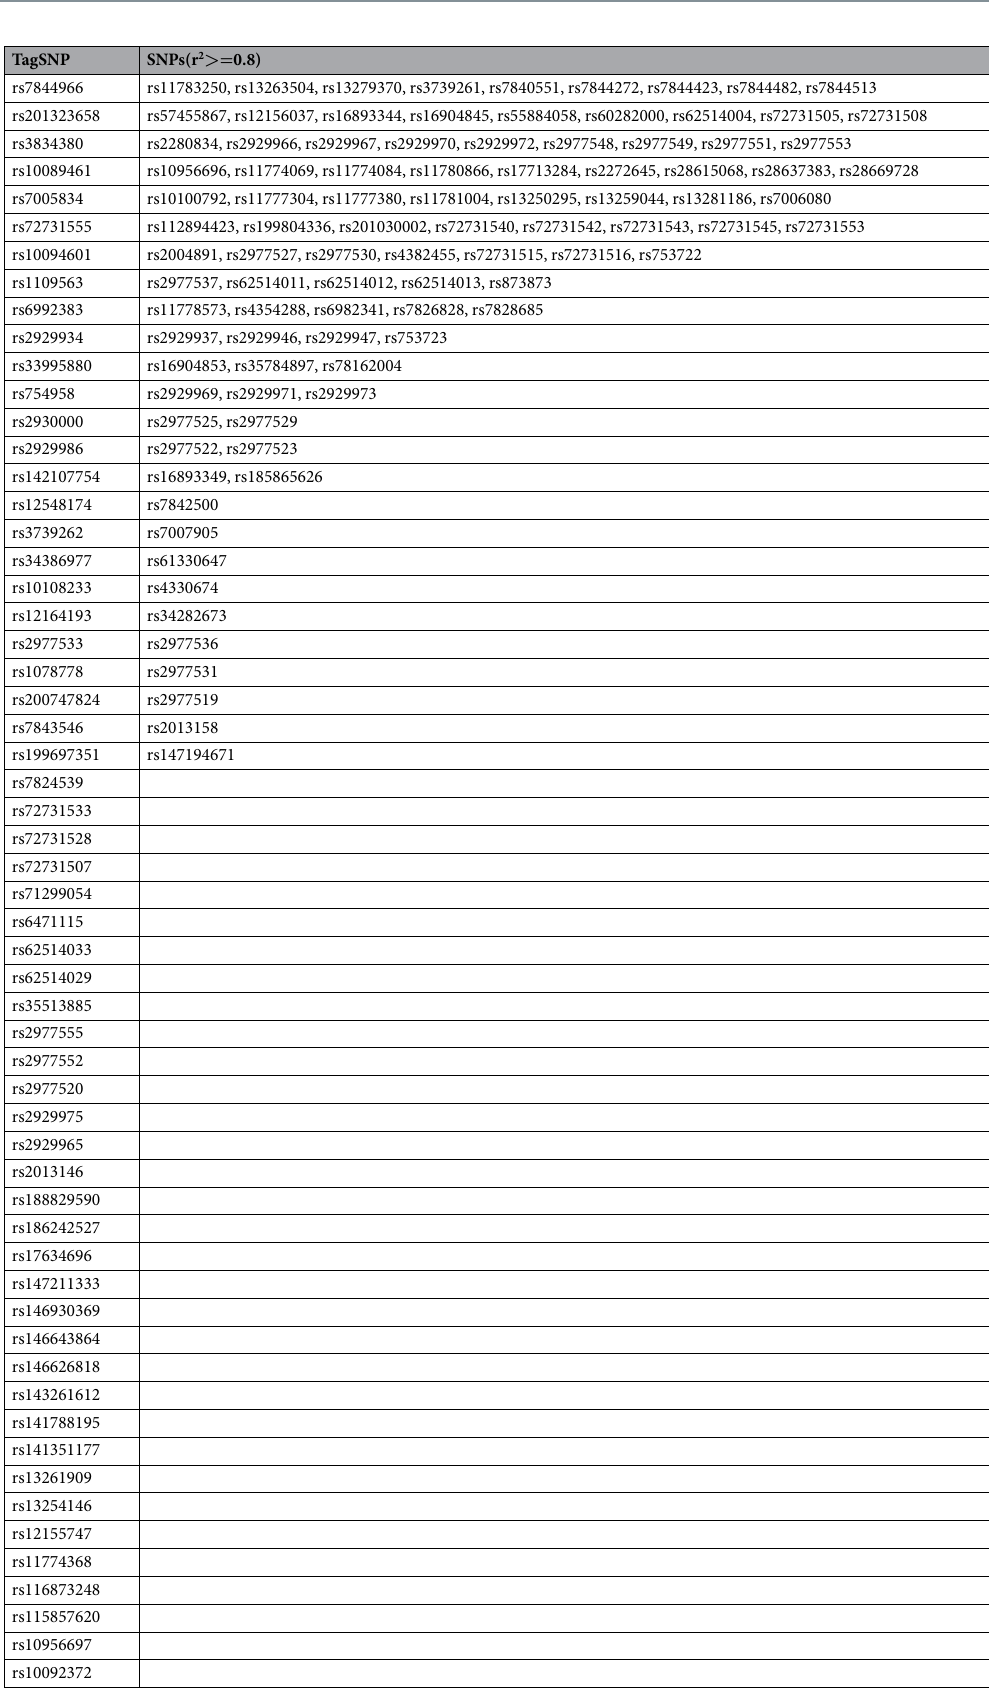
Table 6. Overview of the selected tag